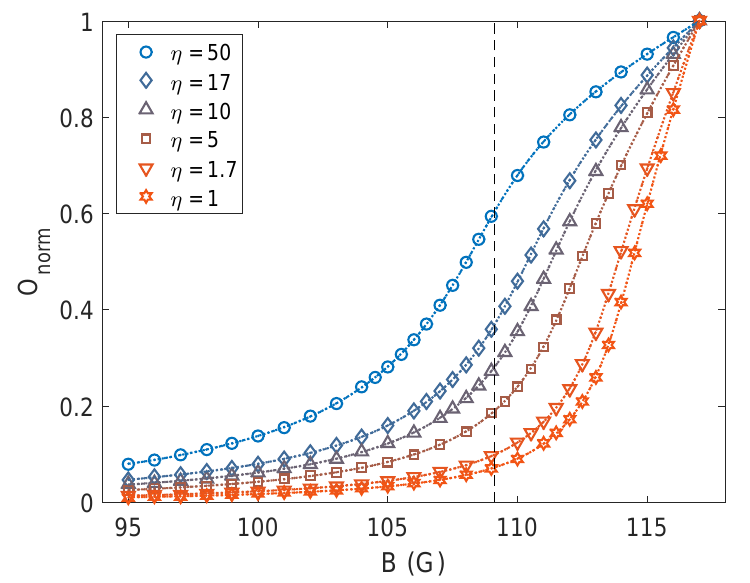
Figure 3. Normalized overlap as a function of the Feshbach field for different values of η . For large η , N K << N Na (blue circles), the spatial overlap increases at earlier magnetic fields showing the > u > 0). In the opposite scenario, for η = 1, transition to the miscible phase for u 2 11 u 22 (with δ 12 N K = N Na (red stars), the normalized spatial overlap significantly increases only for B > 111 G < u < remaining immiscible even if u 2 11 u 22 (with δ 12